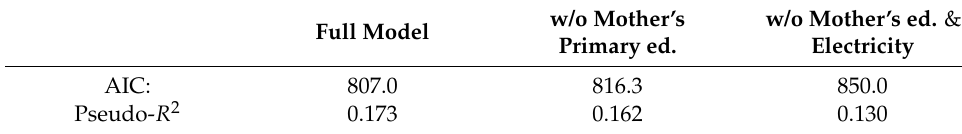
Table 6. Measures of accuracy: AIC and McFadden pseudo- R 2 for Models 1,2,3.